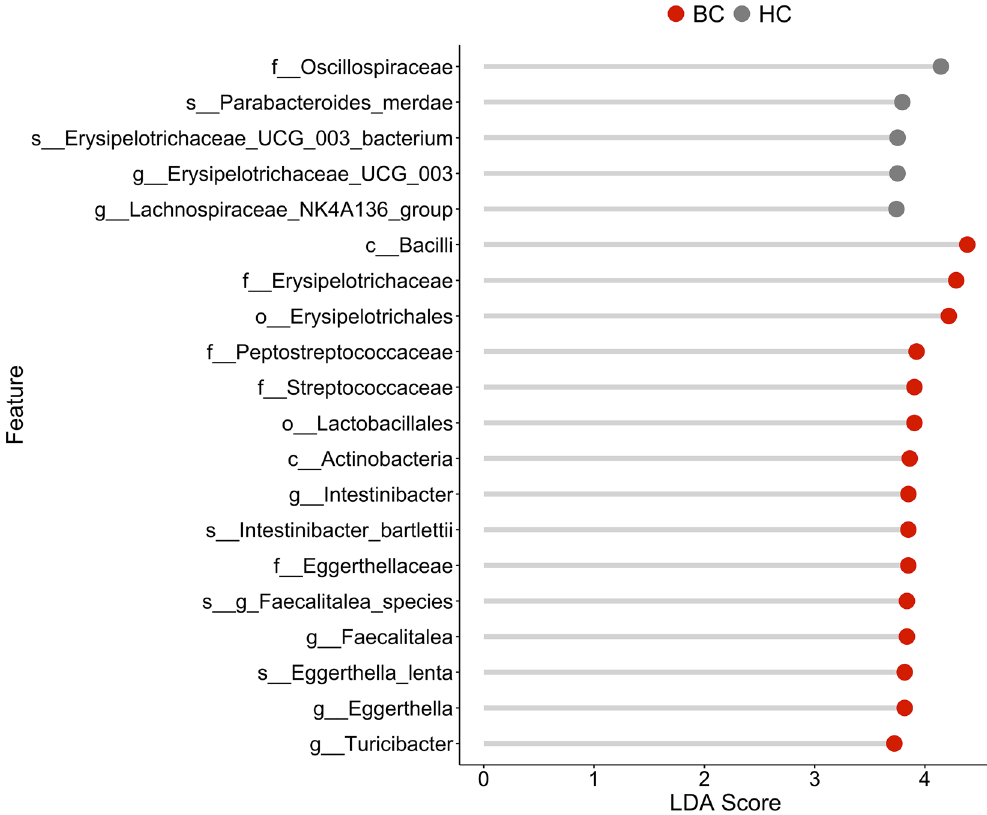
Figure 5. Distinguishing taxa between patients with breast cancer and healthy controls. Top 20 significant features selected by LEfSe analysis. The LDA score indicates the effect size of each